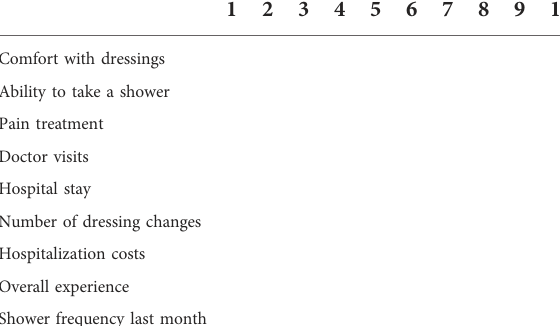
TABLE 2 Questionnaire record